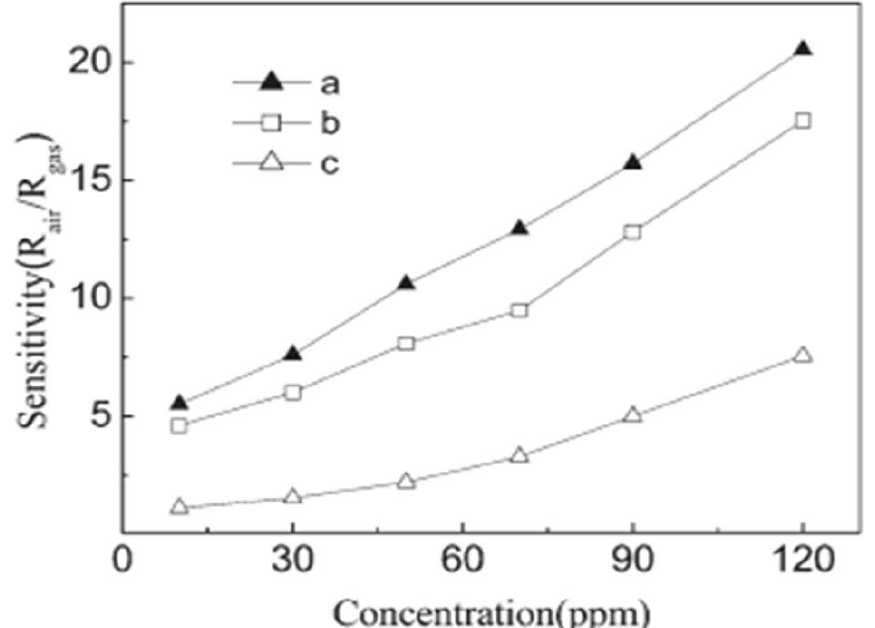
Figure 24. Room temperature sensitivity towards ethanol of ( a ) SnO 2 nanotubes prepared at 45 °C, ( b ) SnO 2 nanotubes prepared at 90 °C and ( c ) SnO 2 nanowires prepared at 45 °C. (Reprinted with permission from [72]. Copyright 2011, American Chemical Society, Washington, DC, USA).